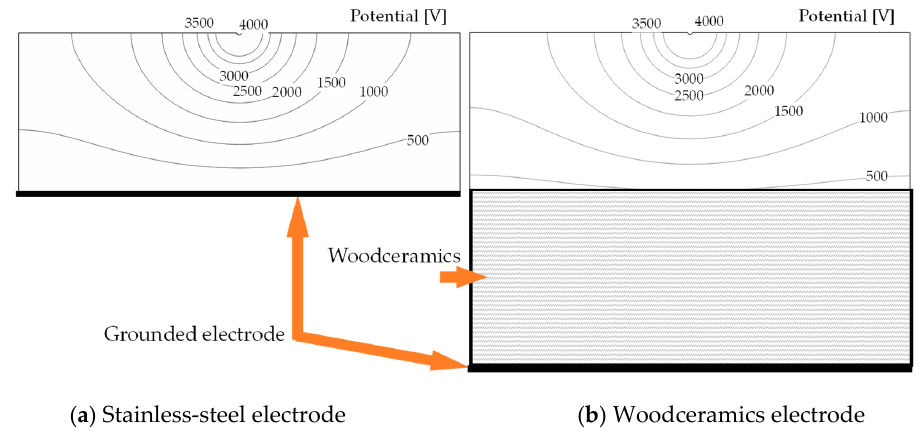
Figure 2. Electrical potential of the corona electrode structure with the ( a ) stainless-steel grounded electrode and ( b ) woodceramics grounded electrode. The bottom side of the woodceramics was grounded, so, the potential near the woodceramics surface was approximately 480 V because of the current flow in the woodceramics.